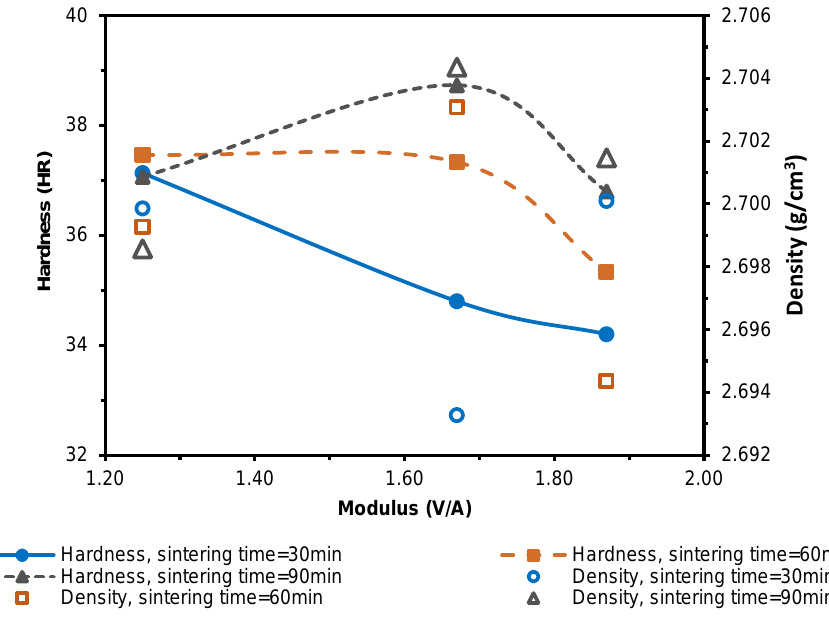
Figure 6. Correlation between hardness and density for Al/7 vol.% SiC p for the different part moduli (sintering temperature: 700 °C).